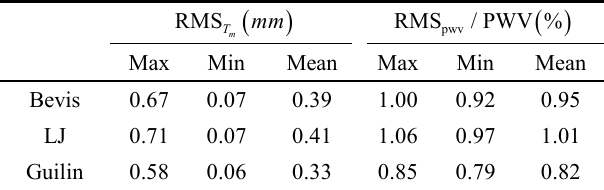
Table 4. The statistical results of errors and relative errors in PWV of 3 kinds of